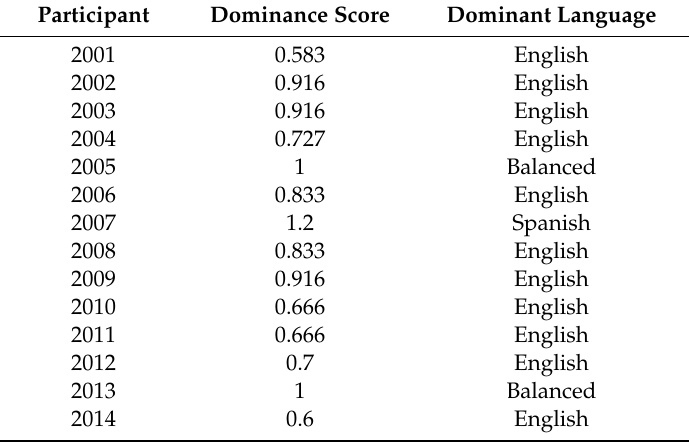
Table A4. Self-ratings of Written Ability individual dominance scores on a ratio of < 1 (English) to > 1